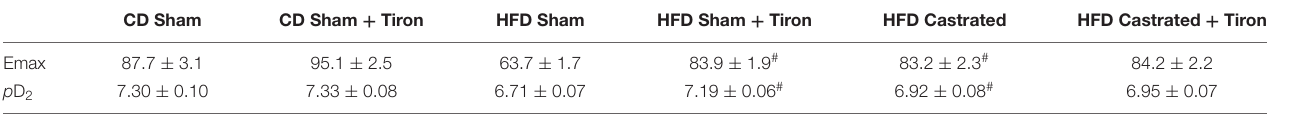
TABLE 3 | Emax and p D 2 values of acetylcholine-induced relaxation in thoracic aorta arteries incubated with vehicle or Tiron. CD Sham CD Sham + Tiron HFD Sham